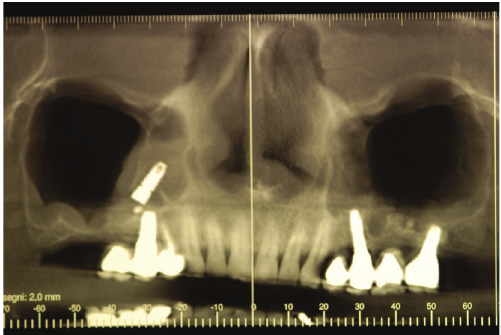
Figure 1: CBCT scans showing a dental implant displaced into the maxillary sinus.